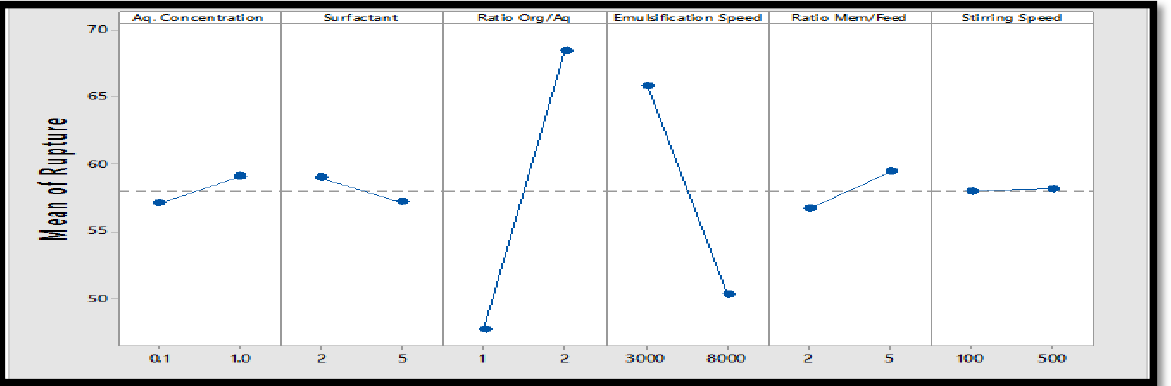
FIG. 2. MAIN EFFECTS PLOT OF PARAMETERS FOR RUPTURE